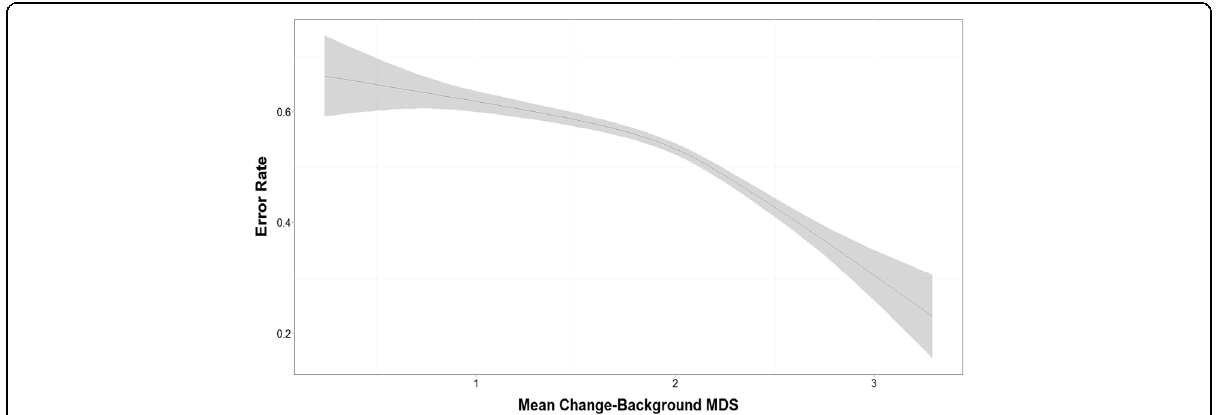
Fig. 6 Trend line with bounds (standard error) showing the relationship between the average similarity (in multidimensional scaling space) between change targets and background sounds as a function of error rate in the change discrimination